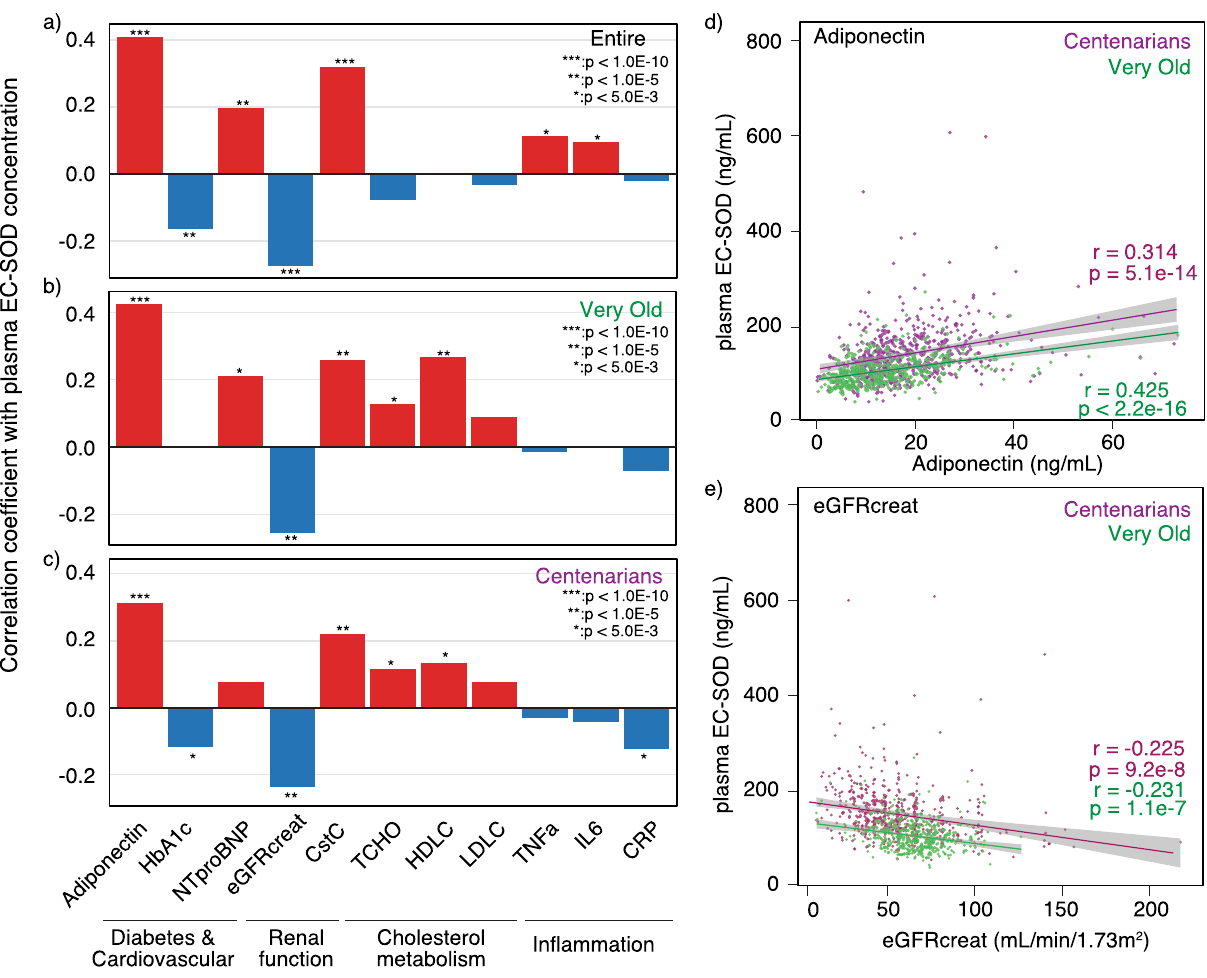
Figure 5. Correlation analysis of EC-SOD concentration with plasma biomarkers for age-related diseases. The bar charts indicate the correlation coefficient (r) between plasma EC-SOD and the concentrations of 11 plasma biomarkers for the entire cohort ( a ), the Very Old ( b ), and Centenarians ( c ). The red and blue bars indicate positive and negative correlations, respectively. The dot plots indicate the association between EC-SOD and adiponectin concentrations in plasma ( d ) and eGFRcreat ( e ) in the Very Old (green) and Centenarians (purple). Lines in the dot plot indicate correlation lines and the gray regions surrounding the correlation lines indicate the area for 95% confidence